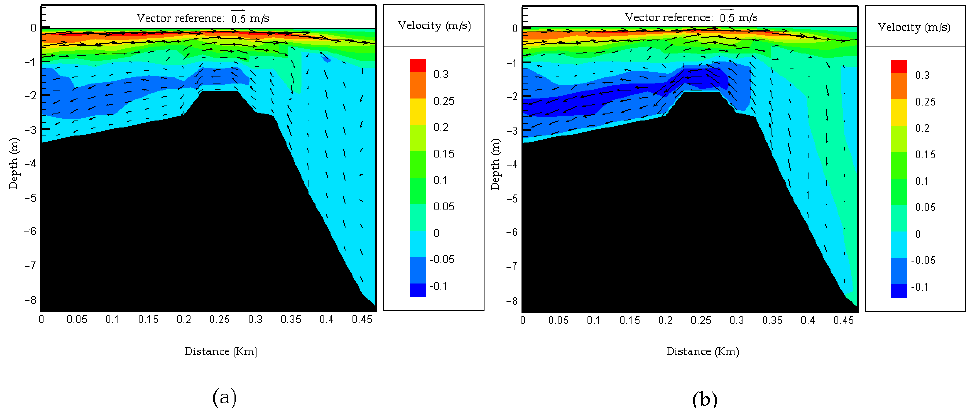
Figure 8. Current pattern on the vertical cross section for discharge of 2 m 3 /s ( a ) low slack water condition and ( b ) high slack water condition.